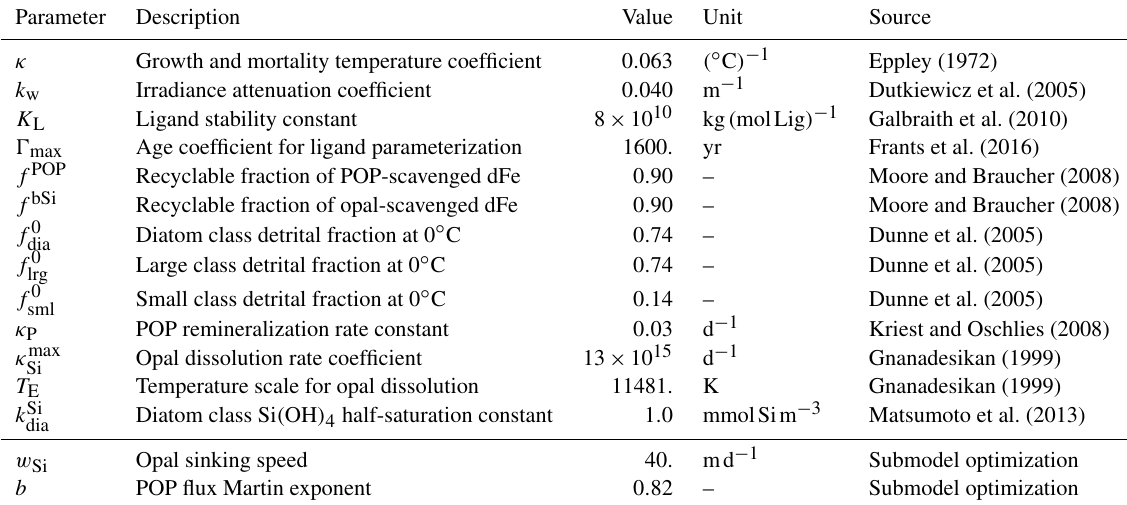
Table 1. Parameters that were prescribed from the literature or that were separately optimized in a submodel.